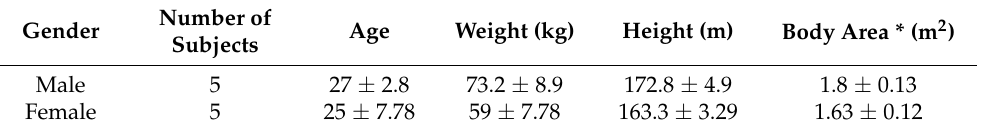
Table 7. Anthropometric data of the subjects.